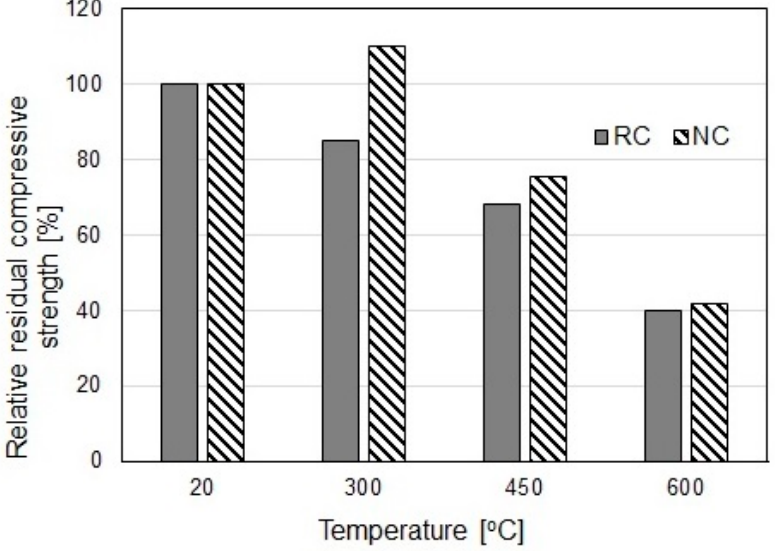
Figure 24. Relative changes in the compressive strength of tested concretes as a function of heating temperature (RC–reference concrete, NC–concrete with 3% of nano-Fe 3 O 4 /SiO 2 ).